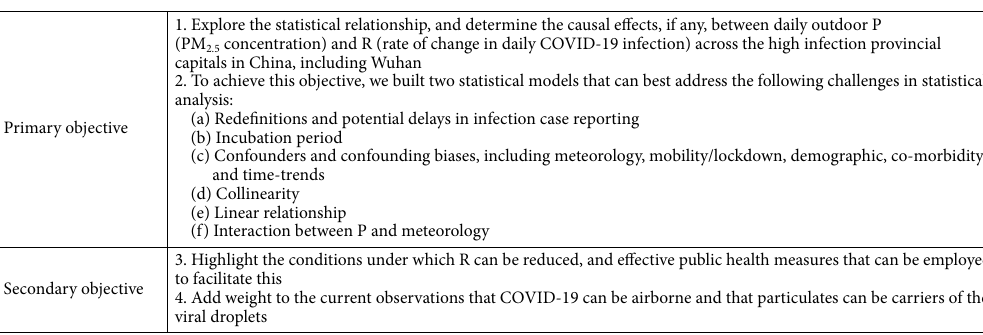
Table 2. Research objectives and